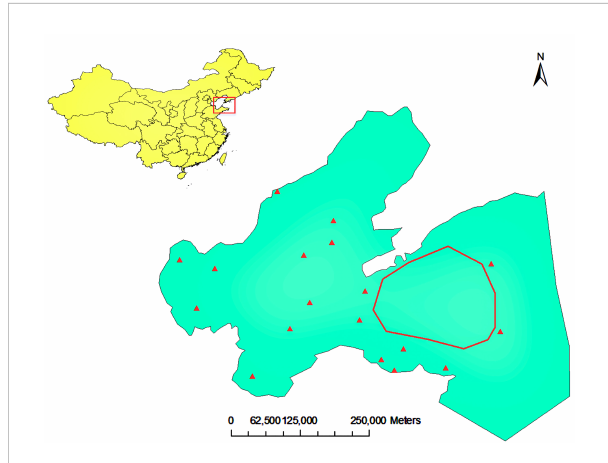
FIGURE 4 Study area and feasible solution space (red triangles are the existing buoy stations and the red polygon area is the feasible solution